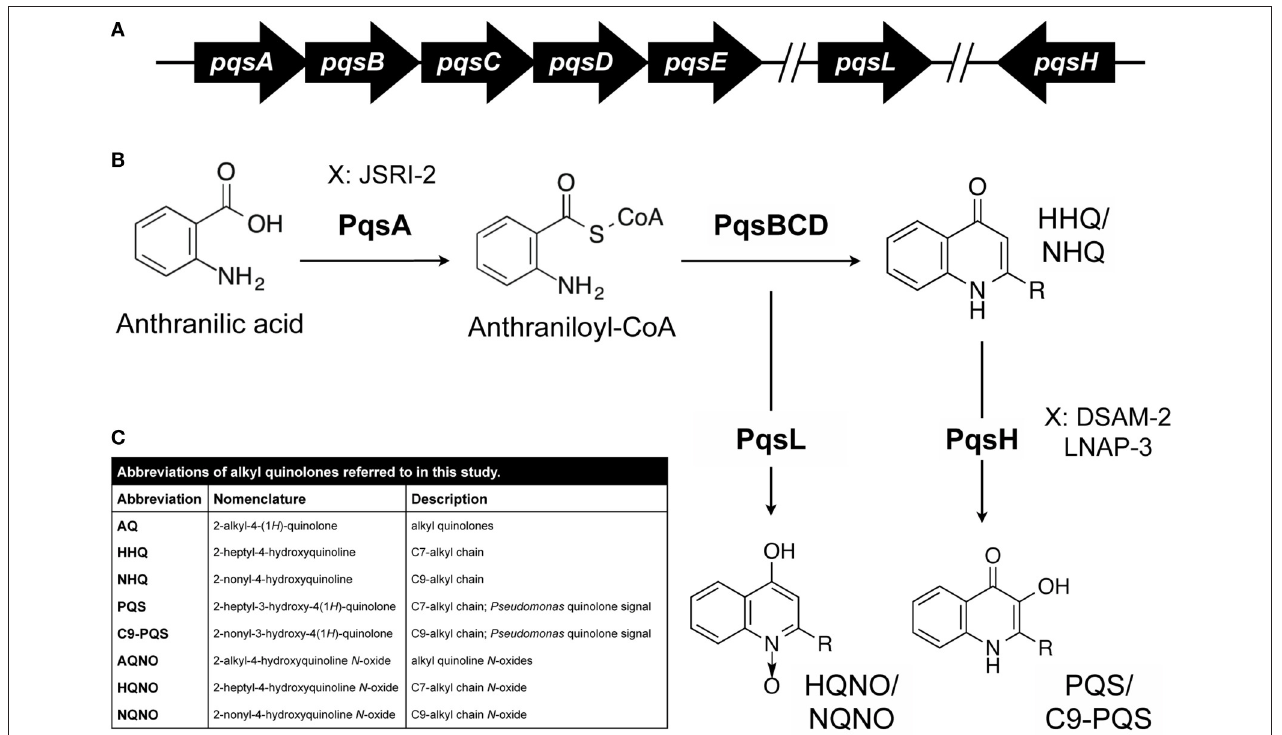
FIGURE 1 | AQ biosynthesis in P. aeruginosa. (A,B) Genetics of AQ biosynthesis. Anthranilic acid is converted to anthraniloyl-CoA by PqsA. The genes encoding PqsBCD, which contributes to the production of HHQ and congeners, are located in an operon with PqsA. The PqsL and PqsH enzymes, which mediate synthesis of HQNO and PQS respectively, and related congeners are encoded at distal sites of the chromosome. Each of these AQ core structures varies with respect to the length and saturation of their alkyl chain (–R). Specific CF isolates of P. aeruginosa (JSRI-2, DSAM-2, and LNAP-3) are hypothesized to defective at distinct steps in the AQ metabolic pathway as indicated. (C) AQ abbreviations used in this study.